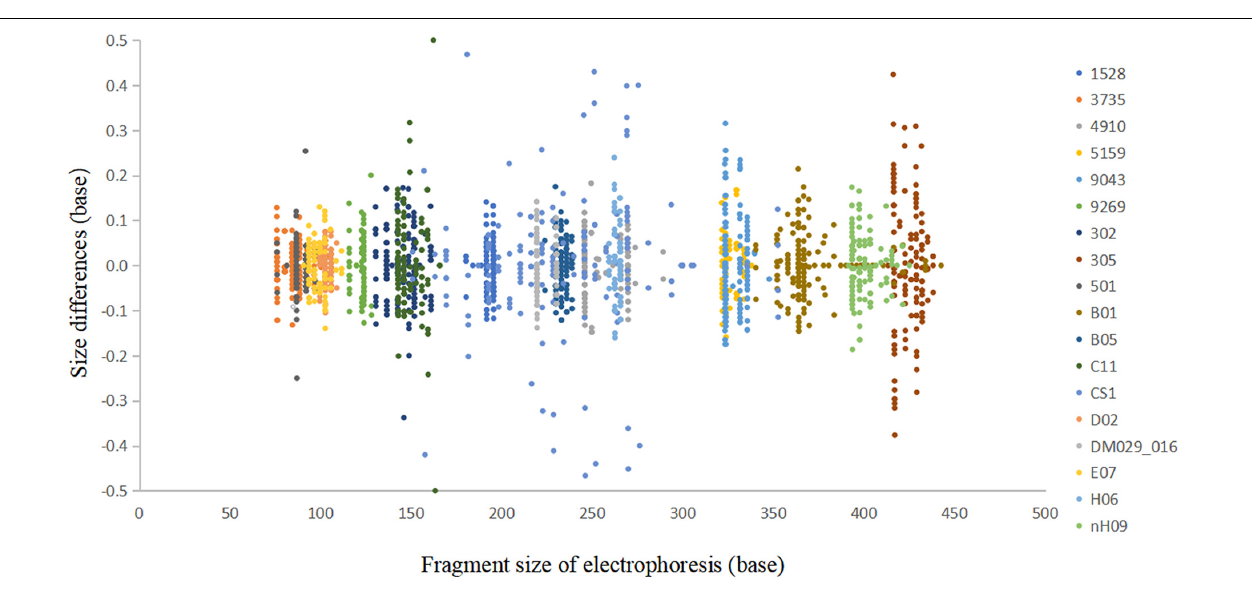
FIGURE 4 | Sizing accuracy study of the Cannabis sativa 19-plex typing system performed on the ABI 3500xl Genetic Analyser. These data represent a total of 2,705 alleles from 100